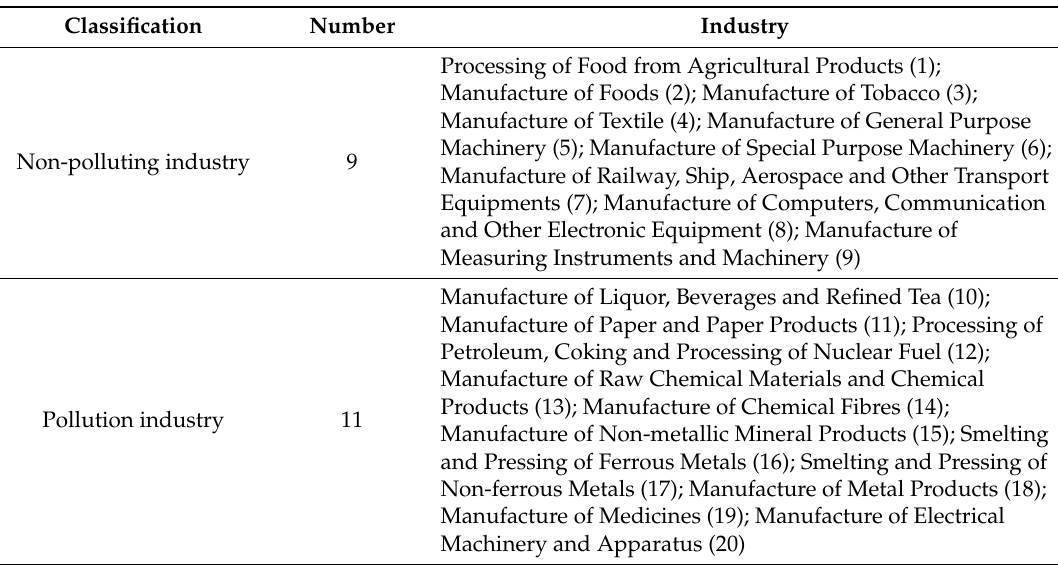
Table 1. Classification of 20 industrial manufacturing